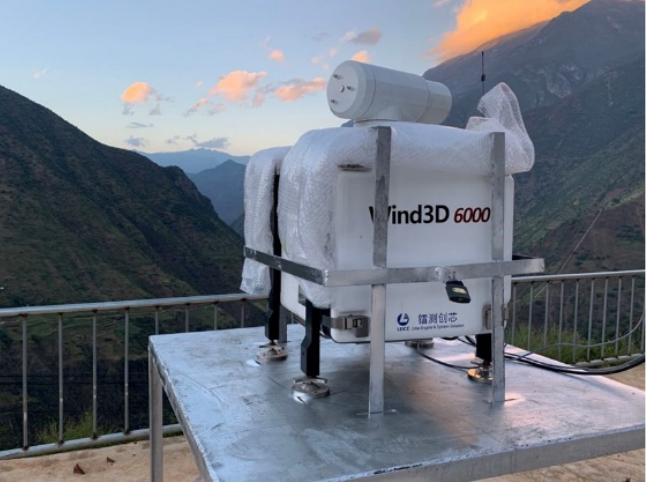
Figure 4. Diagram of the lidar.